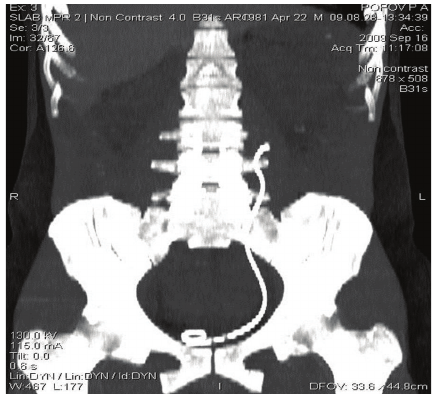
Figure 3: Distal migration of the ureteric